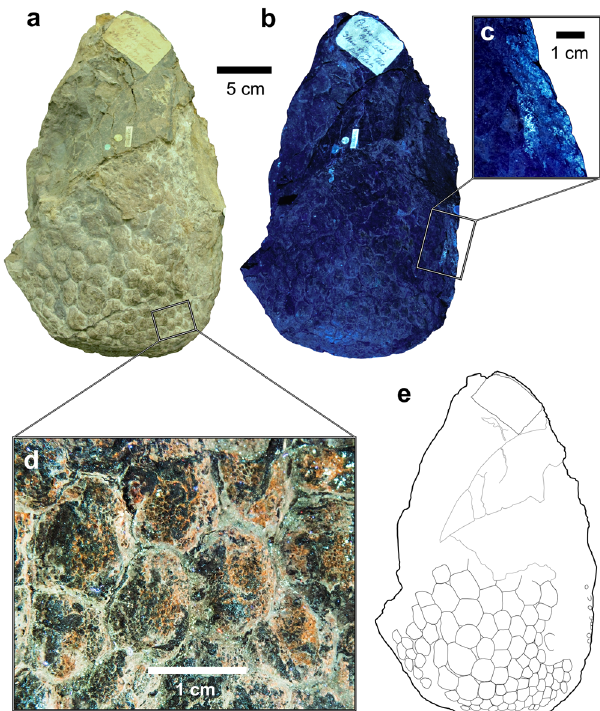
Fig. 1 ‘ Side A ’ of NHMUK R1868, showing relatively large subrounded or polygonal scales (pentagonal – heptagonal) with generally positive